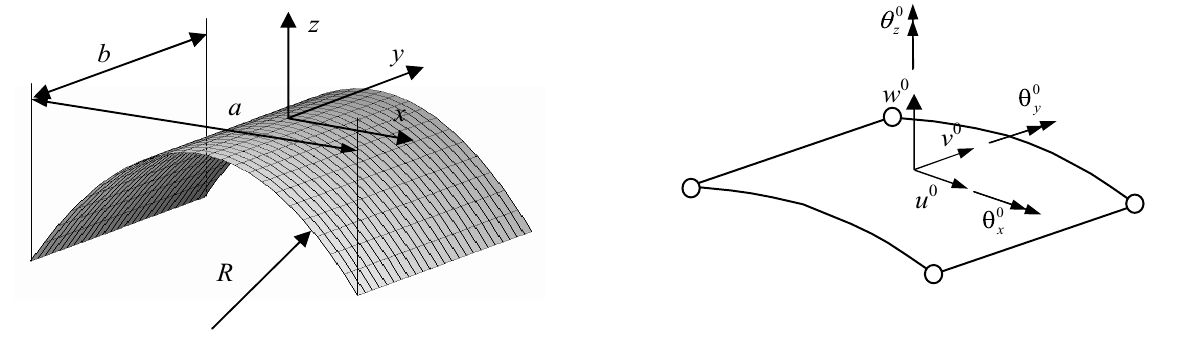
Fig. 1. Shell and shell